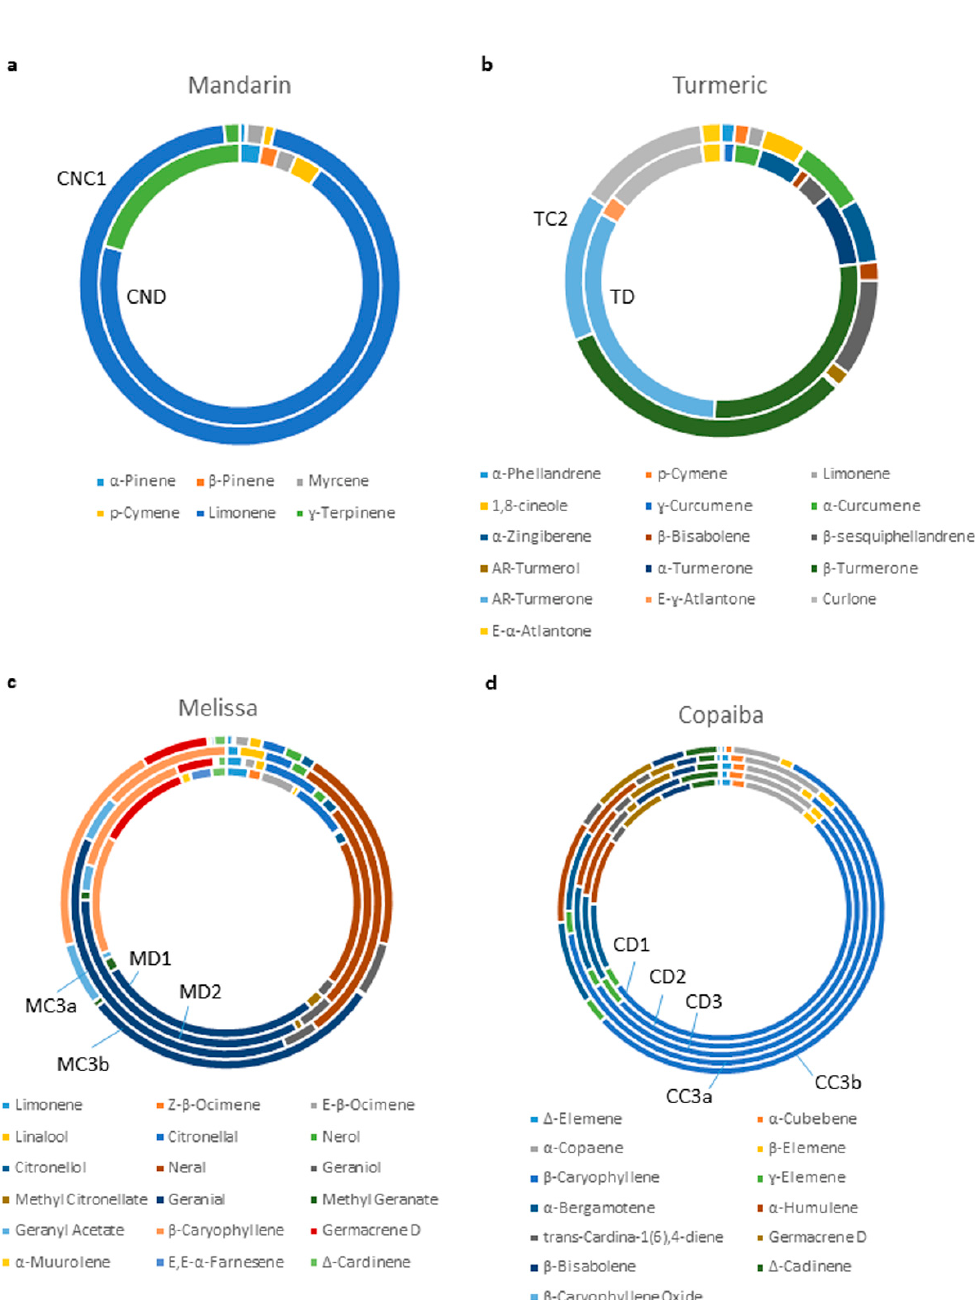
Figure 6. Chemical composition of essential oils. Chemical compositions of selected principle components of ( a ) mandarin essential oils CND and CNC1, ( b ) turmeric essential oils TD and TC2, ( c ) Melissa essential oils MD1, MD2, MC3a, and MC3b, and ( d ) copaiba essential oils CD1, CD2, CD3, CC3a, and CC3b.